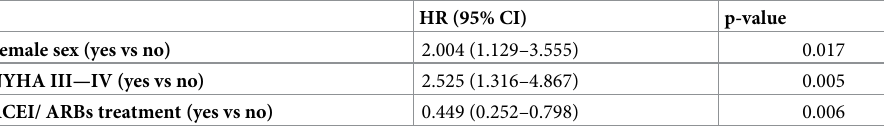
Table 4. Predictors of all-cause of 1- year mortality in AHF patients (multivariable analysis).